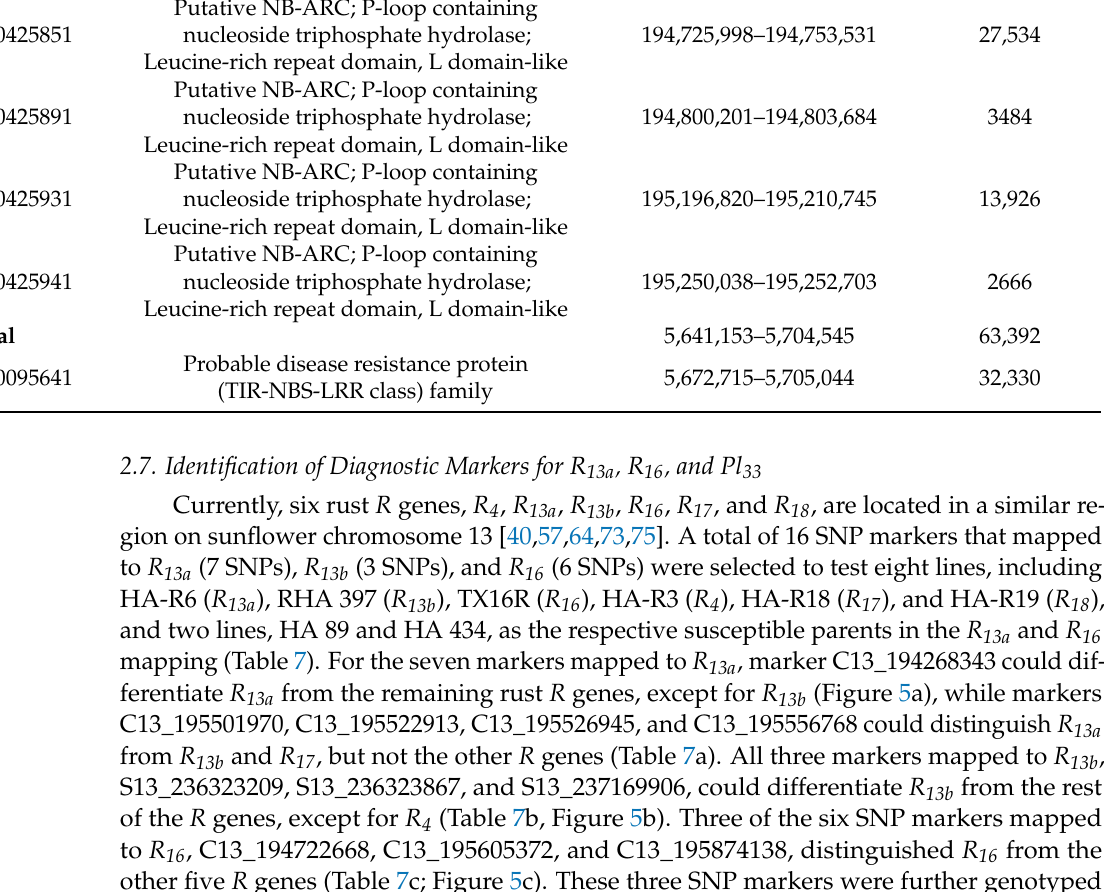
Table 7. ( a ) Specificity test of SNP markers linked to R 13a in eight lines, ( b ) Specificity test of SNP markers linked to R 13b in eight lines, ( c ) Specificity test of SNP markers linked to R 16 in eight lines. ( a )